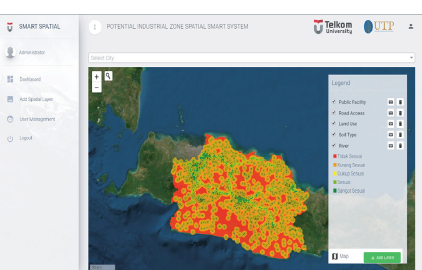
Figure 8: Satellite image (map background).